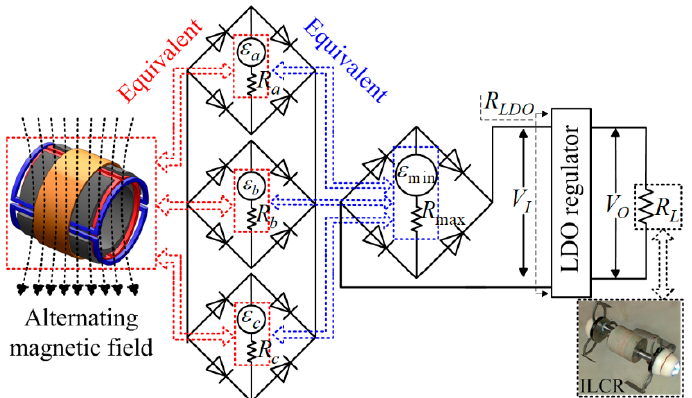
Figure 6. Circuits for converting the induced EMFs of windings a, b, and c to a steady DC voltage for powering the ILCR. The induced EMFs ε a , ε b , and ε c are firstly rectified by three full-bridge rectifiers that each is composed of four Schottky diodes, then superimposed in parallel, and finally regulated by a LDO regulator. The red and blue dotted lines indicate the equivalent process of the power source.